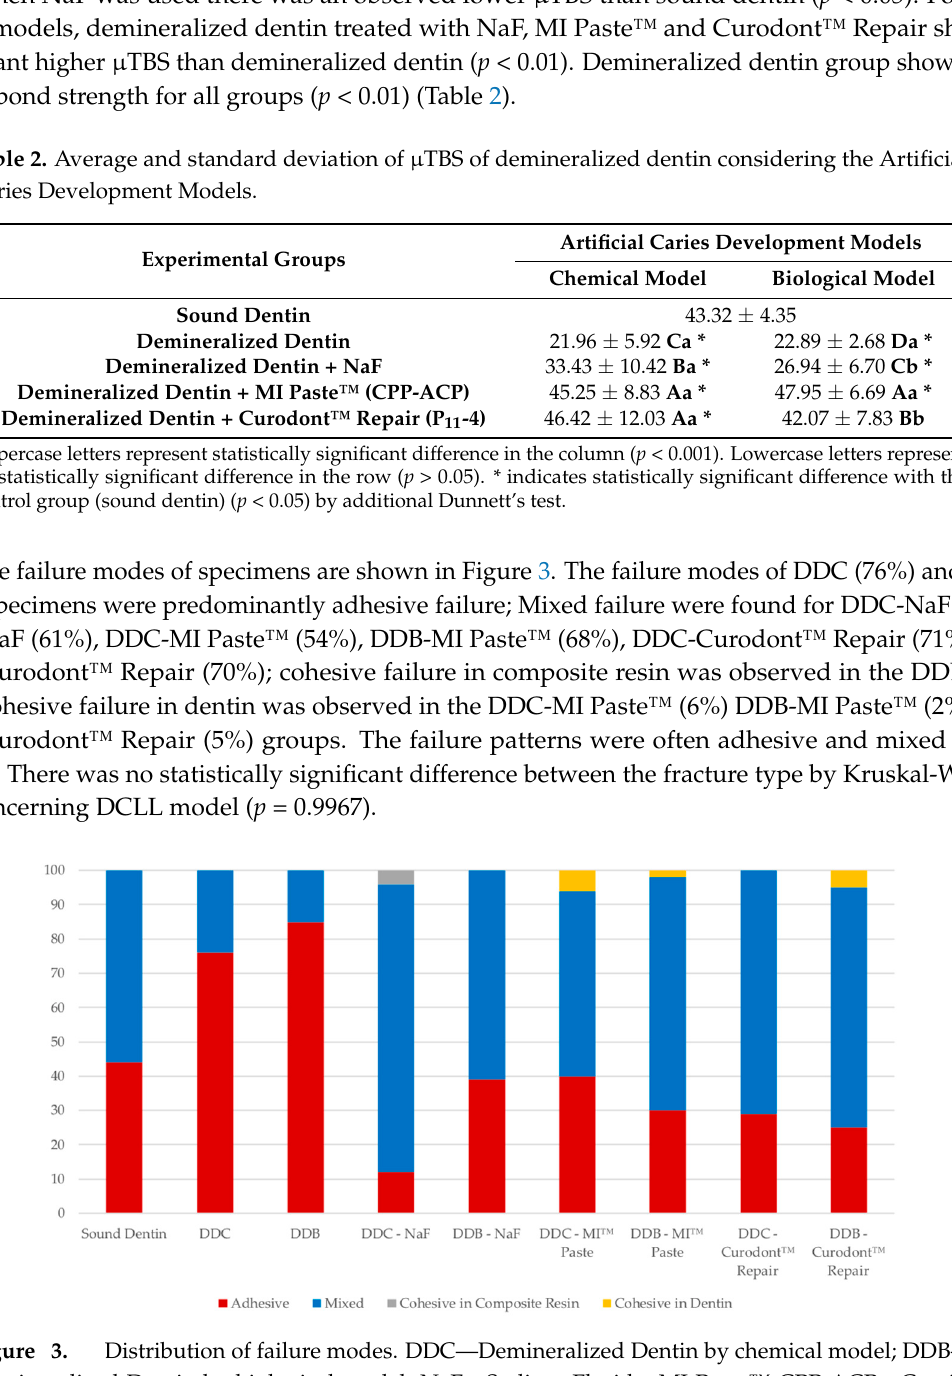
Figure 4. SEM image of failure modes. ( A ) Cohesive failure in Resin Composite; ( B ) Adhesive failure; ( C ) Mixed failure and ( D ) Cohesive failure in Dentin. Abbreviations shows areas of Co . Composite; Ad . Adhesive; De . Dentin. 4. Discussion Considering the studies of bond strength on resin/dentin interfaces, the quality of the dentin substrate can play a key role in the longevity of the bonding [24,27–29]. In the present study, we have evaluated the influence of artificial caries development models (chemical and biological) and substrate conditions on resin/dentin bond strength. In this study, the first null hypothesis that there is a difference between DCLL models producing was proved, since there was no significant influence of the DCLL model on μ TBS of demineralized dentin. However, the second hypothesis that there is influence of DCLL model and demineralized dentin treatment on μ TBS of an etch and rinse adhesive system was rejected, since the μ TBS values were dependent of DCLL model and mineralizing agent type. The highest μ TBS were found when demineralized dentin was treated with for Curodont™